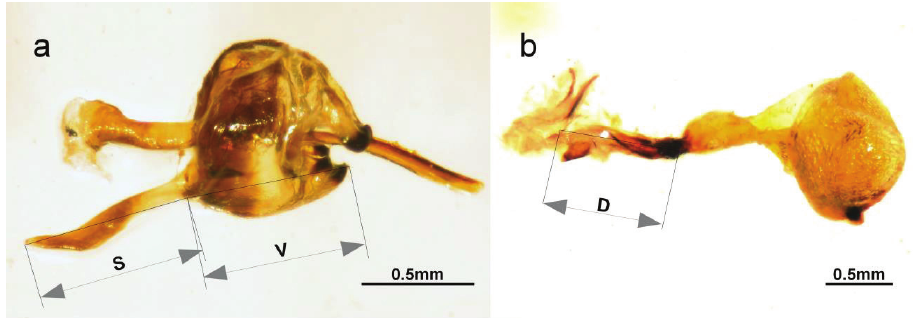
Figure 3. Male ( a specimen L12) and female ( b specimen L45) genitalia of Leptidea juvernica , with measured parameters indicated, namely the length of the saccus (S), valve (V) and ductus bursae